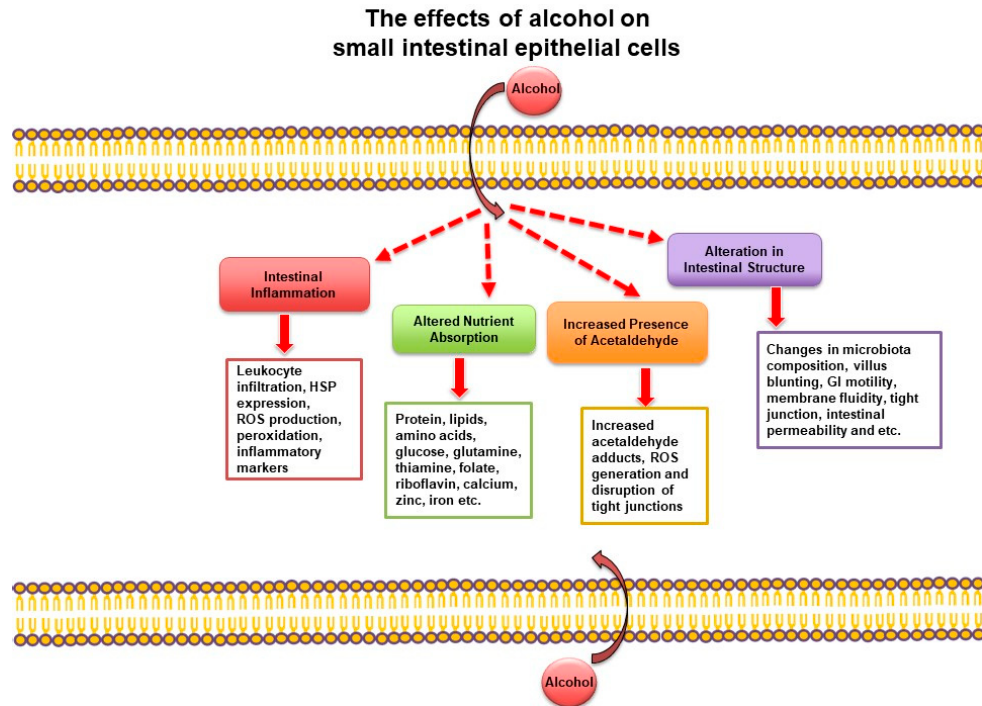
Figure 1. General effects of alcohol consumption on the small intestine. Adapted with permission from Bu tt s M.R. [32]. GI, gastrointestinal; HSP, heat shock protein; ROS, reactive oxygen species.